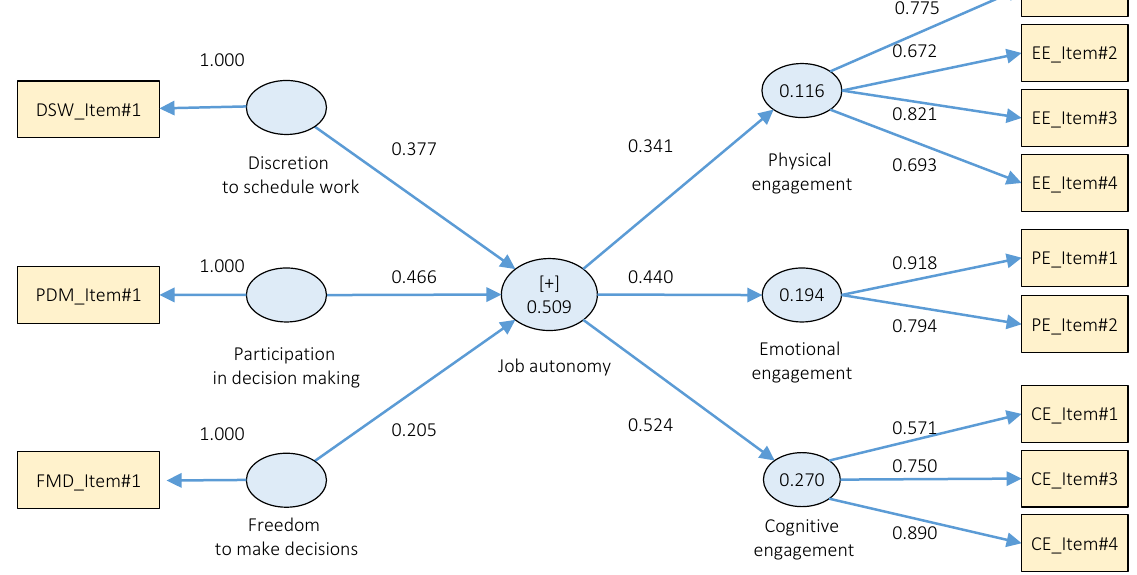
Figure 1. Predictive relevance (path co-efficient) of job autonomy and employee work